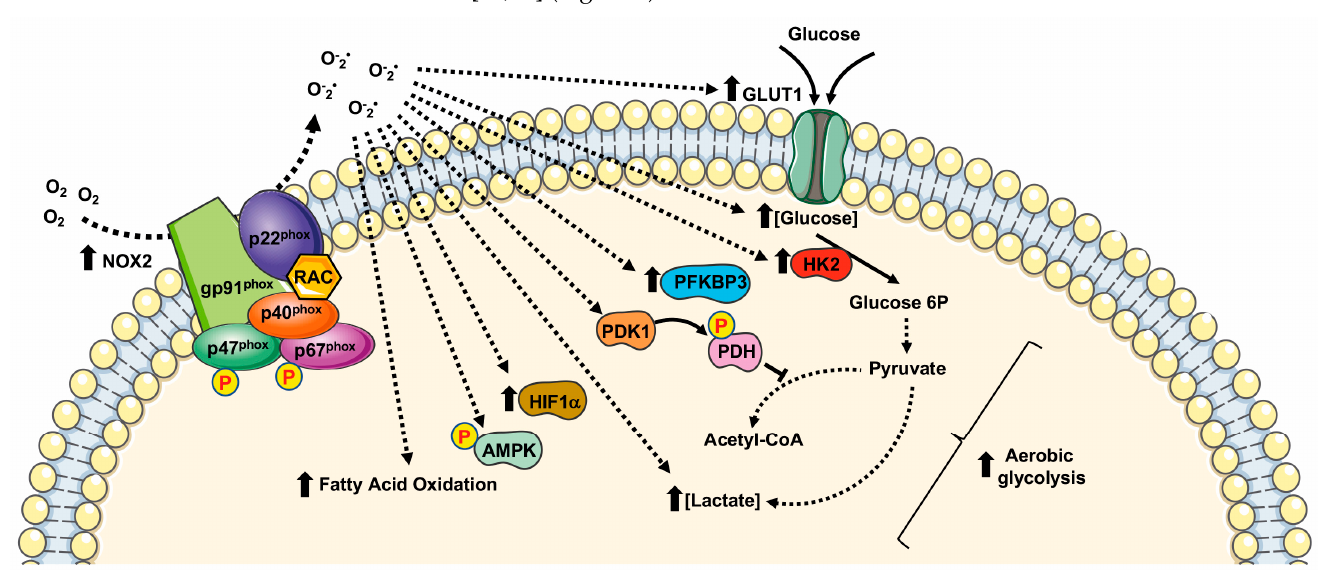
Figure 2. Metabolic pathways supported by NOX2 expression and NOX2-related ROS